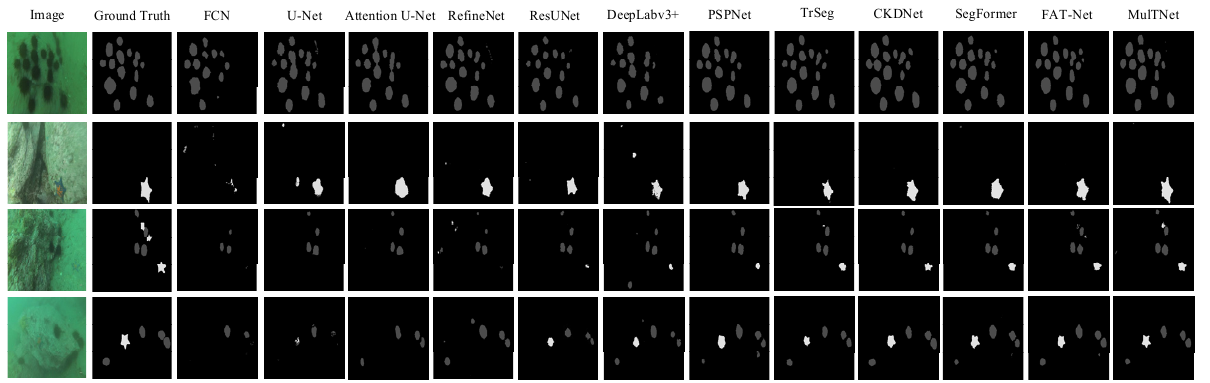
Figure 2. Examples of the marine animal segmentation obtained by FCN-8s, U-Net, Attention U-Net, RefineNet, ResUNet, Deeplabv3+, PSPNet, TrSeg, CKDNet, SegFormer, FAT-Net, and the proposed MulTNet.